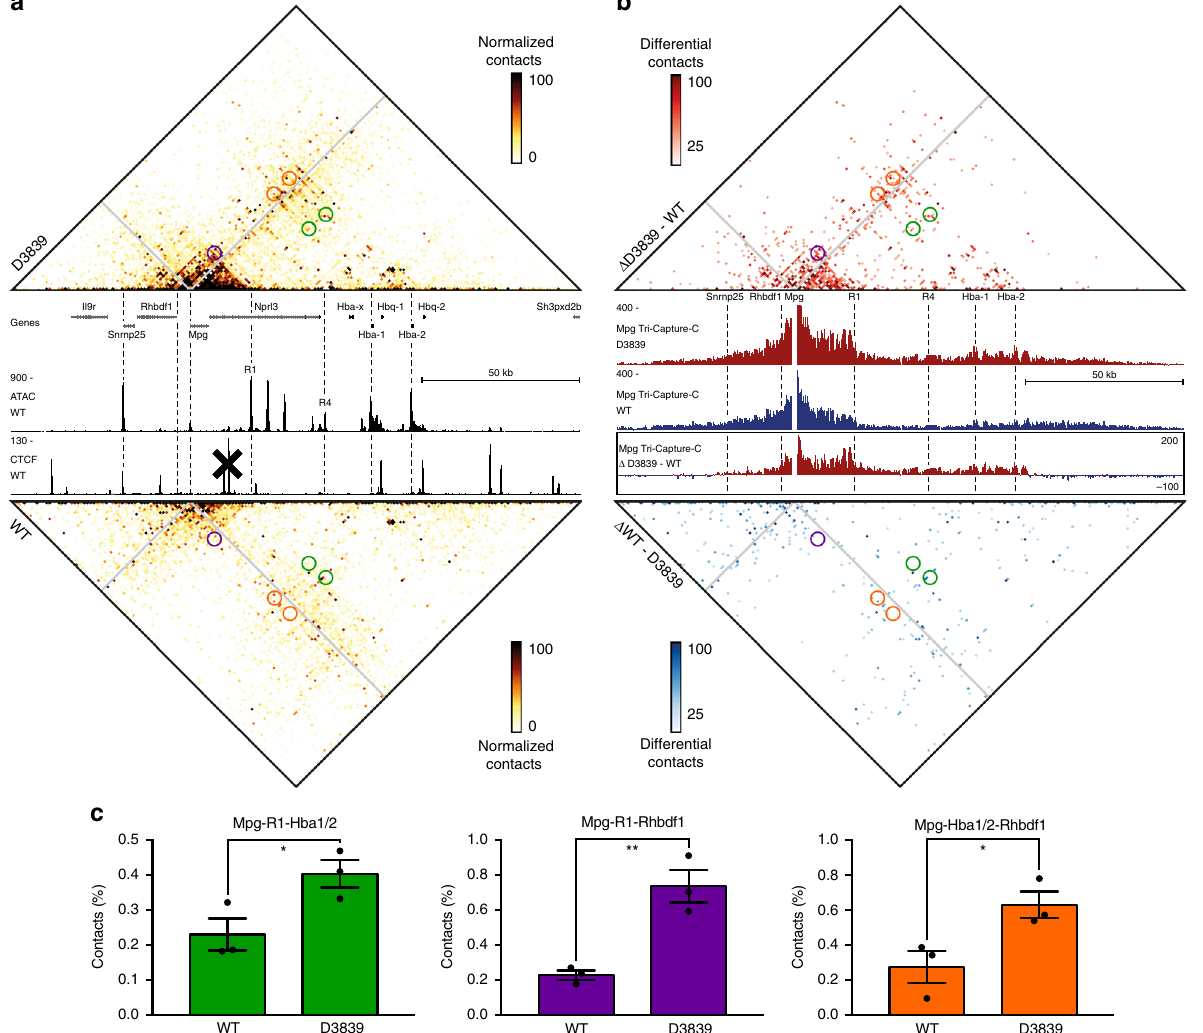
Fig. 3 Deletion of a CTCF boundary results in the formation of a regulatory hub in which multiple gene promoters are incorporated. a Tri-C contact matrices showing multi-way chromatin interactions with Mpg in D3839 (top) and WT (bottom) erythroid cells. Matrices represent mean numbers of normalized, unique contact counts at 1kb resolution in n = 3 biological replicates with proximity contacts around the Mpg viewpoint excluded (gray diagonal). Gene annotation, open chromatin (ATAC), and CTCF occupancy in WT erythroid cells are shown in the middle. Coordinates (mm9): chr11:32,070,000 – 32,250,000. b Tri-C contact matrices showing differential multi-way chromatin interactions with Mpg between D3839 and WT erythroid cells (top) and vice versa (bottom). Pair- wise interaction pro fi les derived from the Tri-C data from the Mpg viewpoint ( Mpg Tri-Capture-C) are shown in the middle (D3839 in red, WT in blue), with a differential pro fi le in the bottom panel. Coordinates (mm9): chr11:32,070,000 – 32,250,000. c Quanti fi cation of multi-way contacts between Mpg , R1 and the α - globin promoters ( Mpg -R1- Hba1/2 , green, P = 0.046); Mpg , R1 and the Rhbdf1 promoter ( Mpg -R1- Rhbdf1 , purple, P = 0.0064); and Mpg , the α -globin promoters and the Rhbdf1 promoter ( Mpg - Hba1/2-Rhbdf1 , orange, P = 0.040). Quanti fi ed contacts are highlighted with corresponding colors in the matrices above. Numbers represent the proportion of these three-way contacts relative to the total in the matrix and are averages of n = 3 biological replicates, with individual data points overlaid as dot plots and the standard error of the mean denoted by the error bar. P -values were calculated by two-tailed t